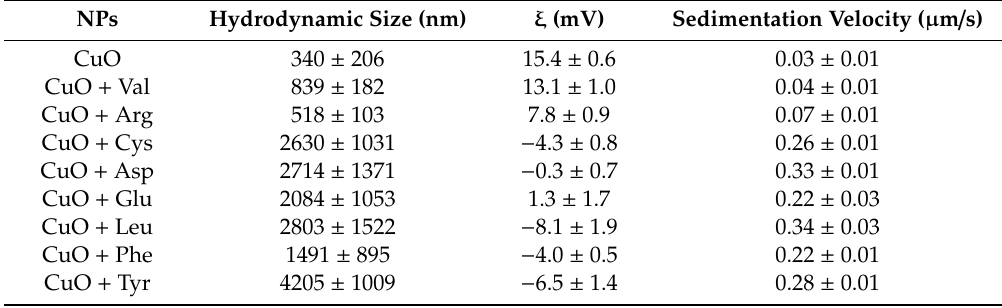
Table 3. Hydrodynamic size, zeta potential ( ξ ) and sedimentation velocity values of pristine CuO NPs and treated with amino acids, dispersed in ultrapure